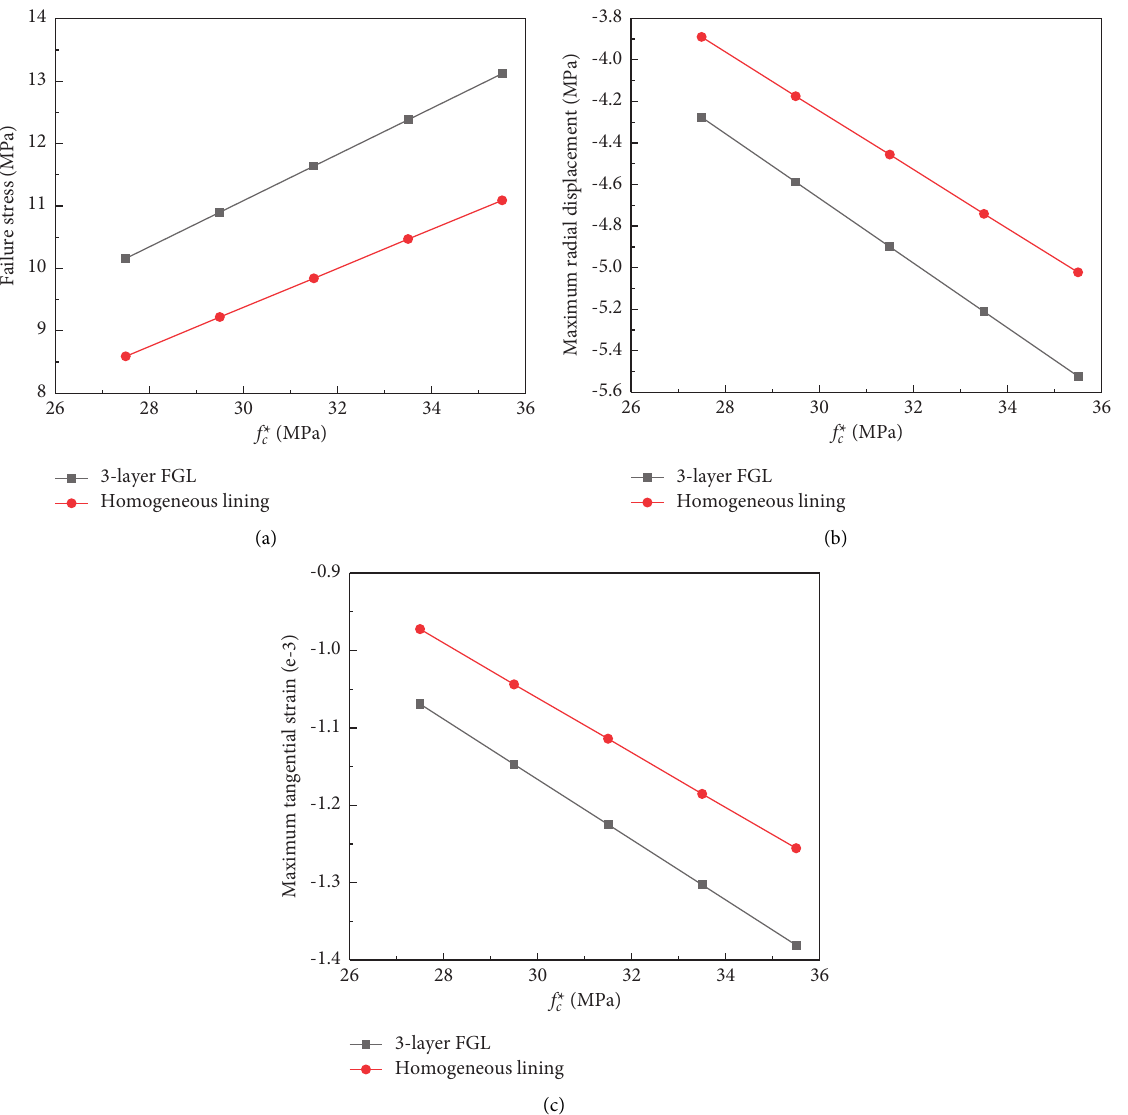
Figure 13: Variations of ultimate bearing capacity, maximum radial displacement, and maximum tangential strain with concrete . (a) Ultimate bearing capacity. (b) Maximum radial displacement. (c) Maximum tangential compressive strength f ∗ c